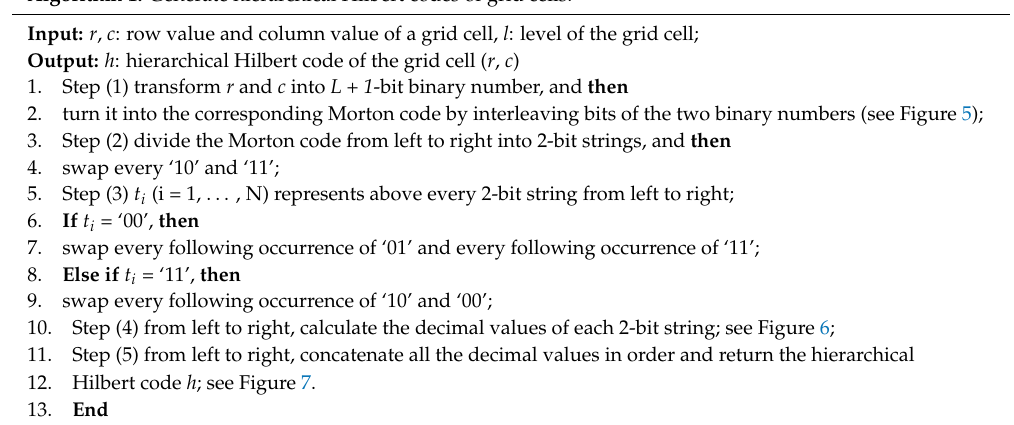
Algorithm 1. Generate hierarchical Hilbert codes of grid cells.